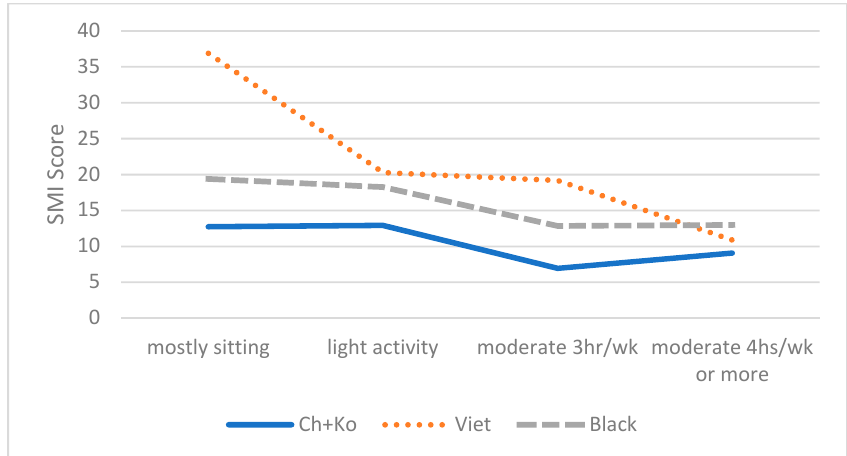
Figure 3. Effect of Physical Activity on SMI by Groups.